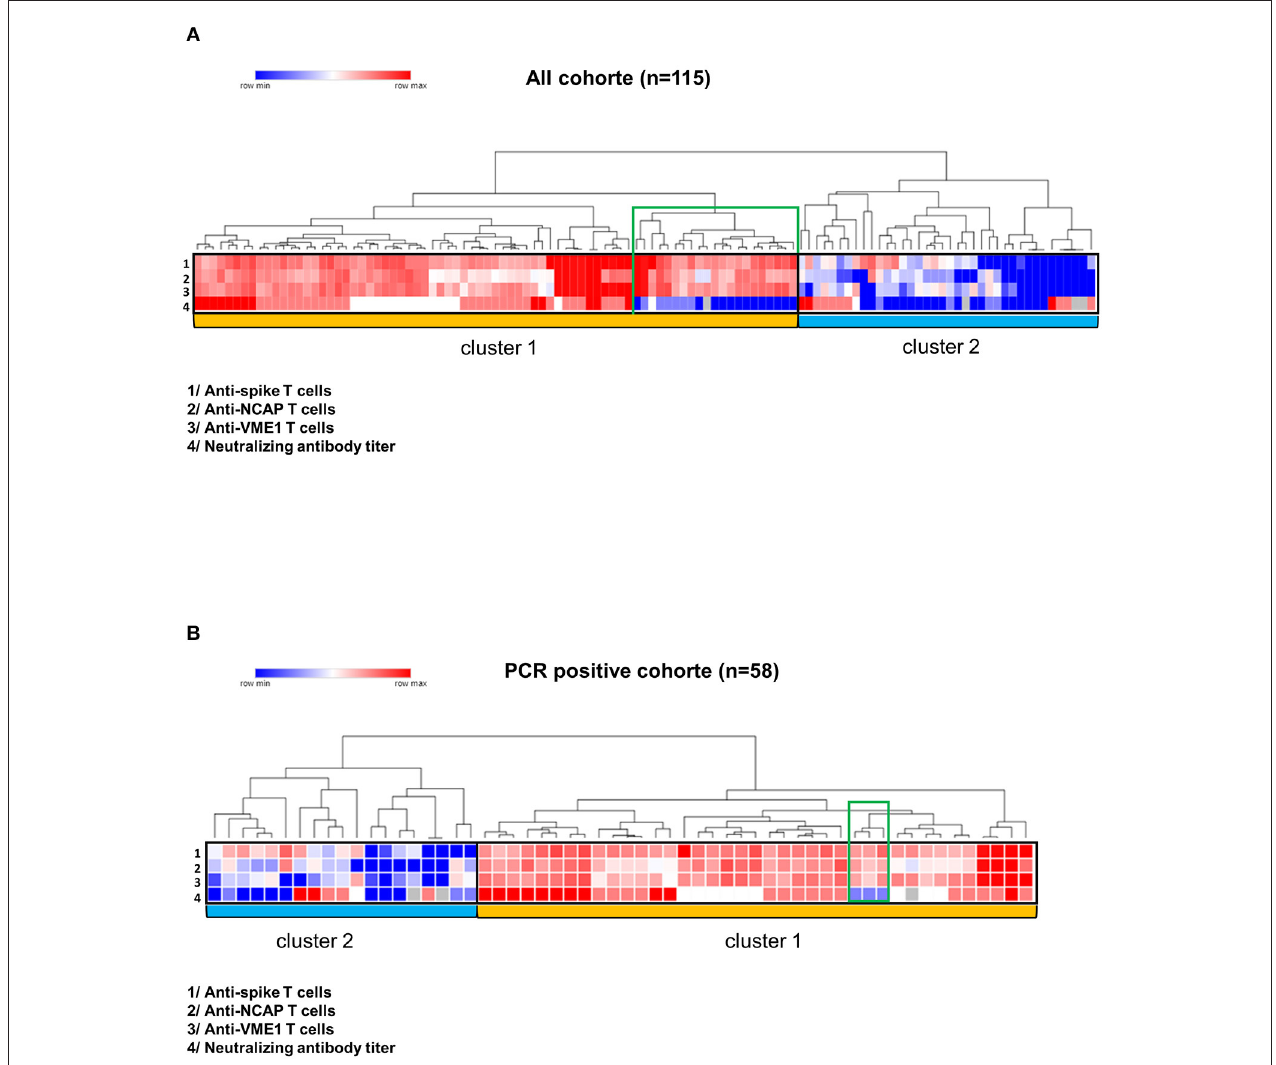
FIGURE 3 | Correlation between T cell responses and neutralizing antibody titers. Heat maps were performed using the online Morpheus software (https://software. broadinstitute.org/morpheus/). Antibody neutralizing titers were defined as negative ( < 1:40), low (1:40), intermediate (1:80) and high ( ≥ 1:160). T cell responses against the spike glycoprotein, NCAP and VME1 were defined as negative (lower than 10 spots), low (10 to 20 spots), intermediate (21 to 300 spots) or high ( > 300 spots). Unsupervised cluster analysis of immune parameters provided two major clusters (entitled cluster 1 and cluster 2) in all COVIPLASM cohort (A) and in the PCR positive COVIPLASM cohort (B). A small group of CPD (indicated in green on heat map) had no neutralizing antibody titer. CPD, convalescent plasma donor; GP, glycoprotein; NCAP, nucleocapsid; VME1, Membrane